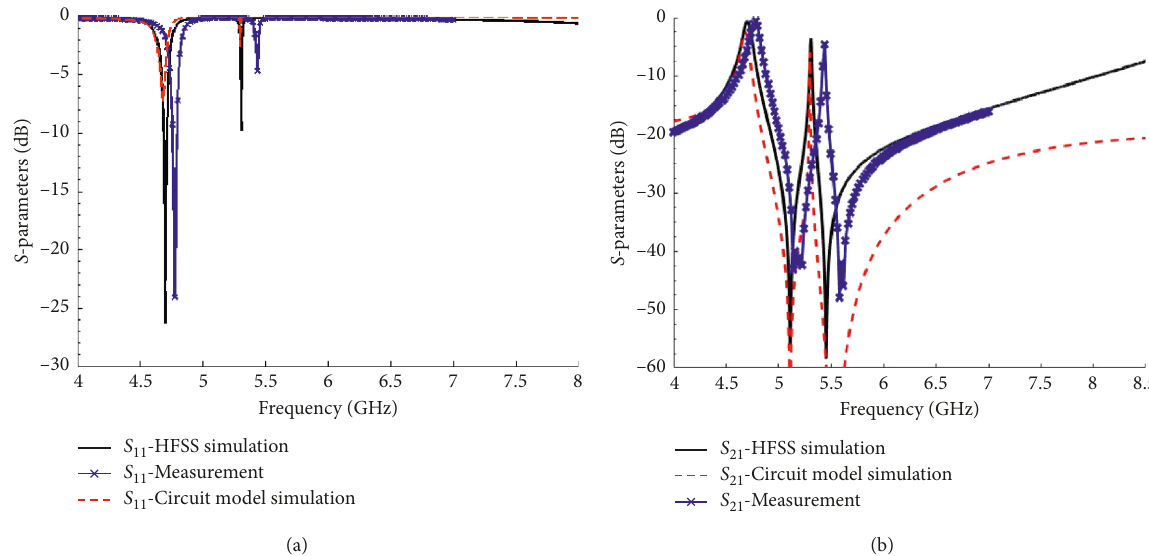
Figure 7: Measured and simulated transmission responses of the first proposed resonator. (a) S 11 parameter and (b) S 21 parameter. The geometrical parameters are L � 2.2mm, g � 0.2mm, a 1 � 3.6mm, a 2 � 3.6mm, a 3 � 1.8 mm, a 4 � 1.2mm, and a 5 � 3.1mm for the upper CSRR and L � 2.4mm, g � 0.2 mm, a 1 � 3.2mm, a 2 � 4mm, a 3 � 2 mm, a 4 � 0.9mm, and a 5 � 3.5mm for the lower CSRR and W � 11.5mm and t � 1.3 mm. The electrical parameters of the equivalent circuit models in this case are L d � 4nH, L c � 1 nH, C c � 0.97pF, L s � 0.9 nH,